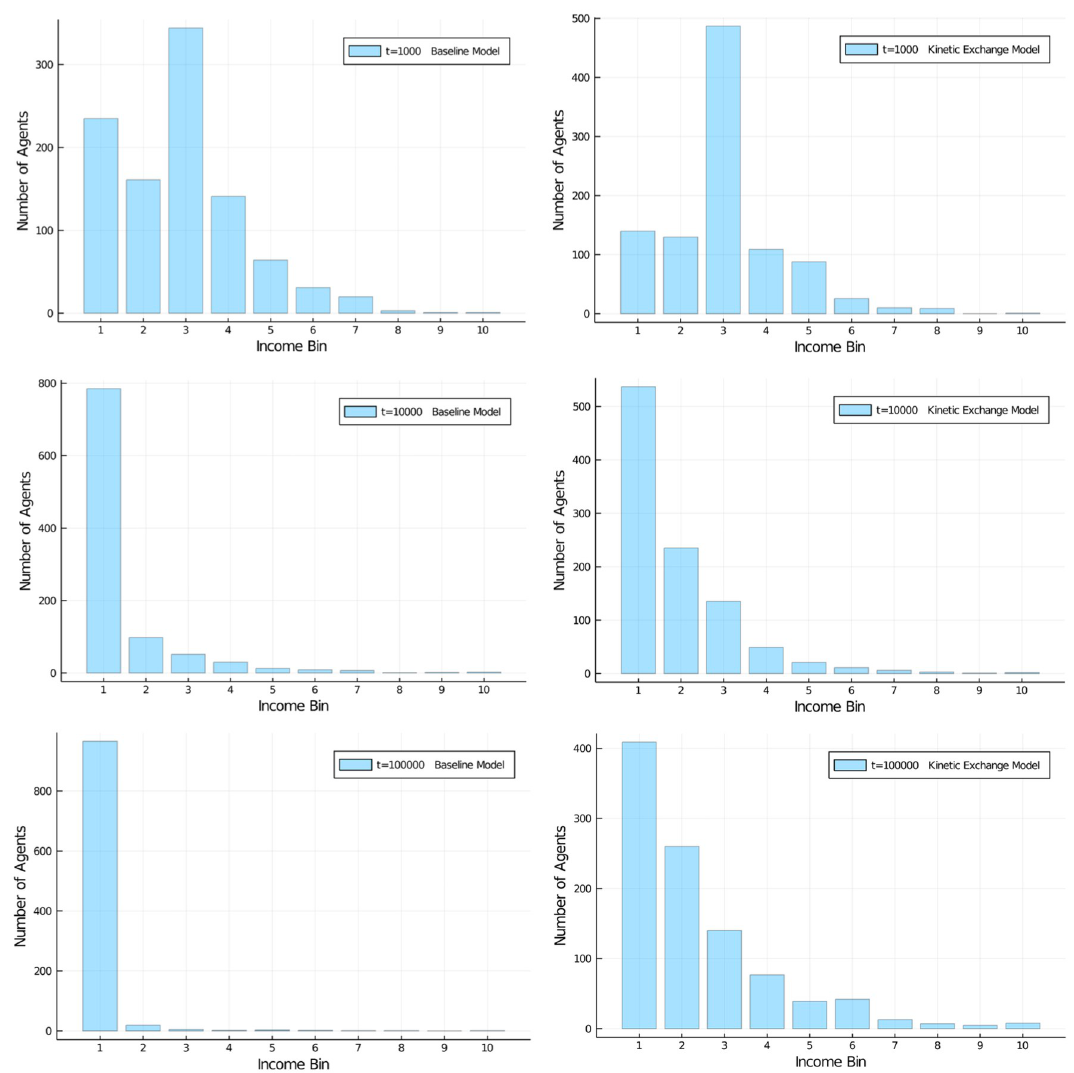
Fig 3. Comparison of Models. Wealth distribution in population of 1,000 agents (10 bins, a.u.). Comparison of baseline economic exchange model (left) and kinetic exchange model (right) at t = 1, 000;10, 000; and 100, 000. Initial distribution was equal among all 1,000